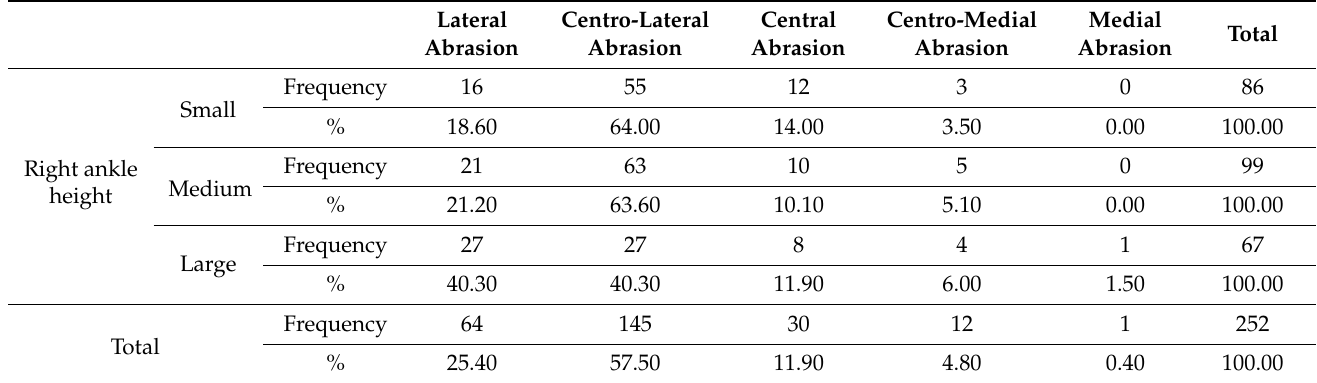
Table 12. Relationship between the right ankle height and left shoe abrasion classification (X 2 = 16.66, df = 8, p = 0.03).